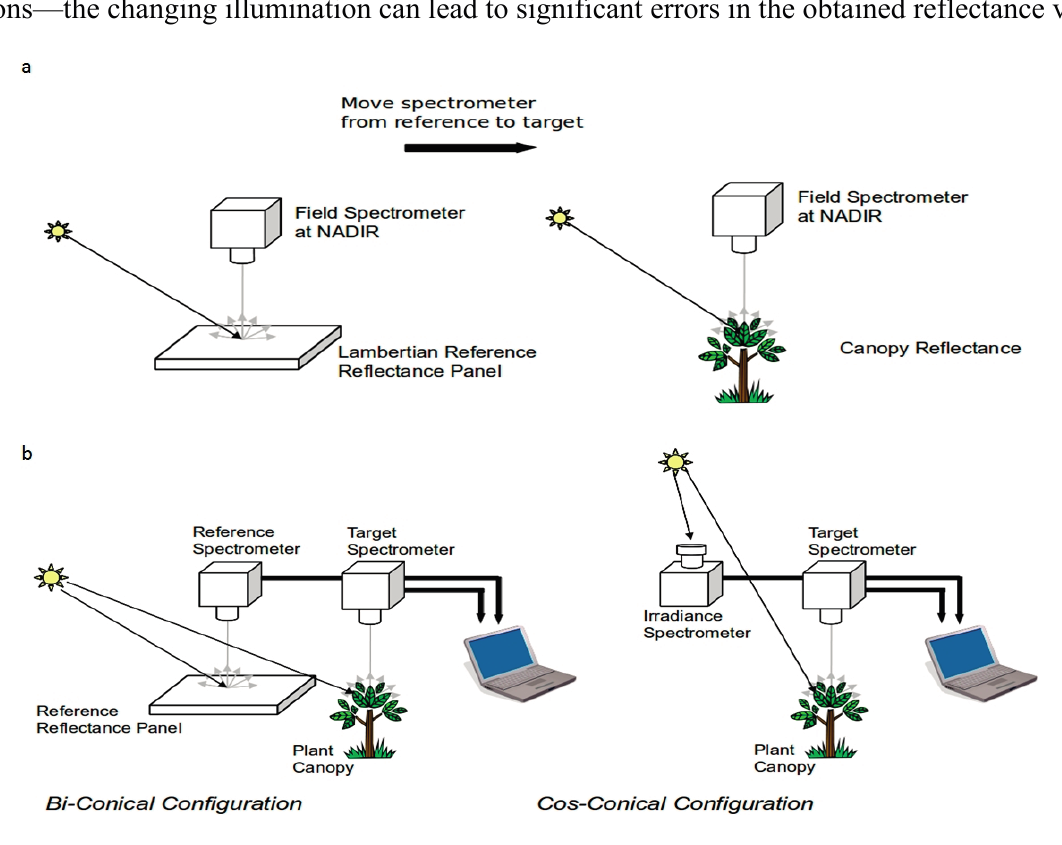
Figure 1. Single Field of View (SFOV, scheme ( a )) and Dual Field of View (DFOV, scheme ( b )) systems (with permission, copyright of NERC, Field Spectroscopy Facility, University of Edinburgh,